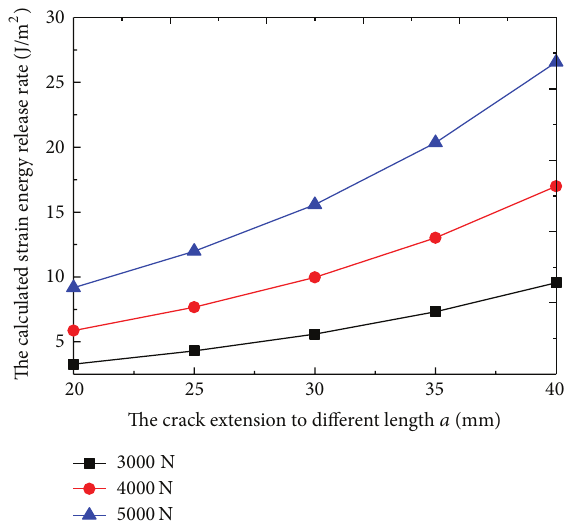
Figure 5: The plot of calculated SERR against the main crack propagation.